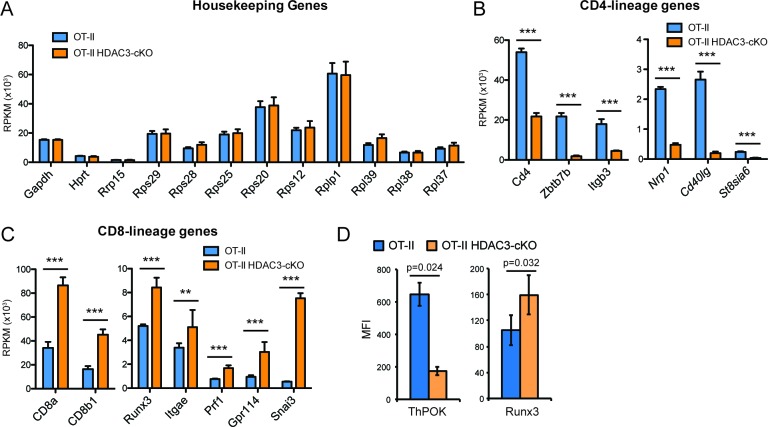
Gene expression of select housekeeping genes, CD4-lineage genes, and CD8-lineage genes.RPKM values of indicated genes of Selecting cells from OT-II and OT-II HDAC3-cKO mice. (A) Housekeeping genes, (B) CD4-lineage genes, and (C) CD8-lineage genes. Bar graphs depict mean ± SEM of three mice. P values (***, p < 0.001, **, p < 0.01) were calculated using the exactTest with edgeR software. Housekeeping genes did not show a significant difference between mice. (D) Protein expression of ThPOK and Runx3 in Selecting cells from OT-II and OT-II HDAC3-cKO. Bar graphs depict mean ± SEM of 3–6 mice per group from at least three independent experiments. P values were calculated using paired t test.